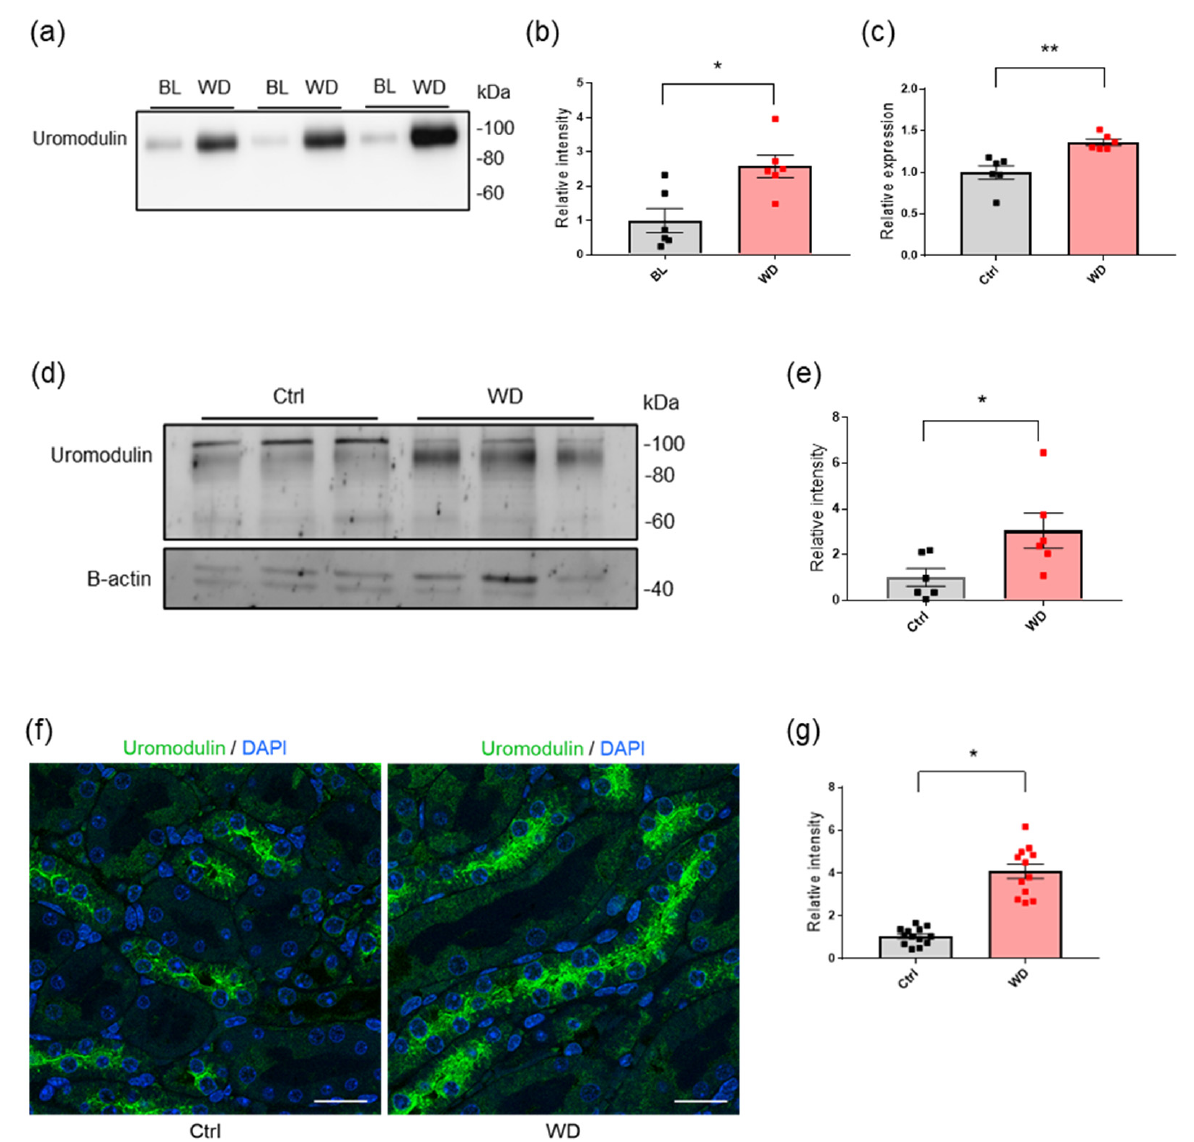
Figure 1. Regulation of uromodulin under water deprivation in WT mice. ( a ) Western blot analysis for urinary uromodulin at baseline (BL) and after 24 h of water deprivation (WD). Levels were normalized to urinary creatinine to account for urine concentration. ( b ) Quantification of uromodulin signals indicated that urinary uromodulin secretion significantly increased after water deprivation. N = 6. * p < 0.05 (Paired t − test). ( c ) Transcript levels of Umod analyzed via RT − PCR of whole-kidney extracts from mice with access to free water (Ctrl) or under water deprivation. Expression levels were normalized to the housekeeping gene, Act β , and were expressed relative to control. N = 6. ** p < 0.01 (Unpaired t − test). ( d ) Western blot analysis for kidney uromodulin from control mice and mice under WD. β− actin was used as the loading control. ( e ) Quantification of signal intensity relative to the control. N = 6. * p < 0.05 (Unpaired t − test). ( f ) Representative immunofluorescence images for uromodulin (green) in kidney sections from control and water − deprived mice. The scale bar indicates 20 µm. ( g ) Quantification of the ratio of uromodulin signal intensities to the tubular area. The analysis was based on at least three microscopic fields of tissue from three mice per group. * p < 0.05 (Unpaired t − test).